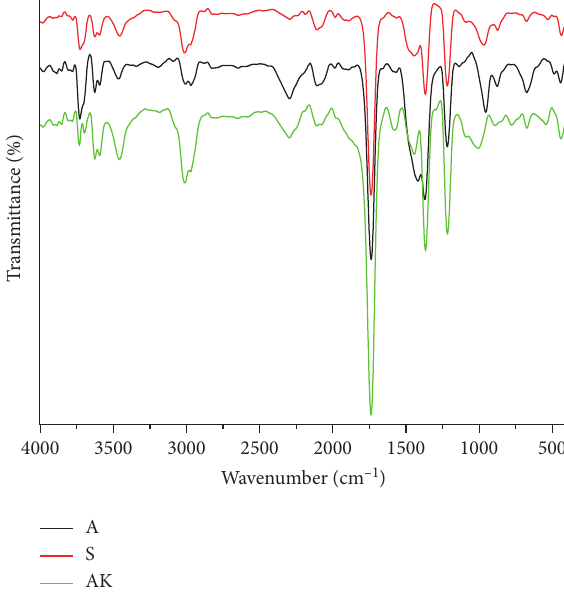
Figure 7: FT-IR image of 2.5M and 1:1 of SH